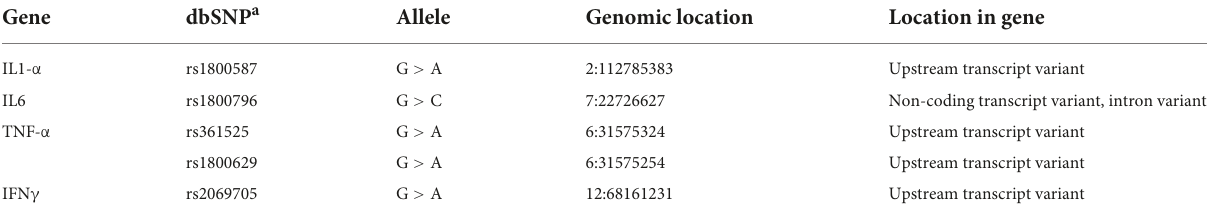
TABLE 1 Reference SNP (rs)